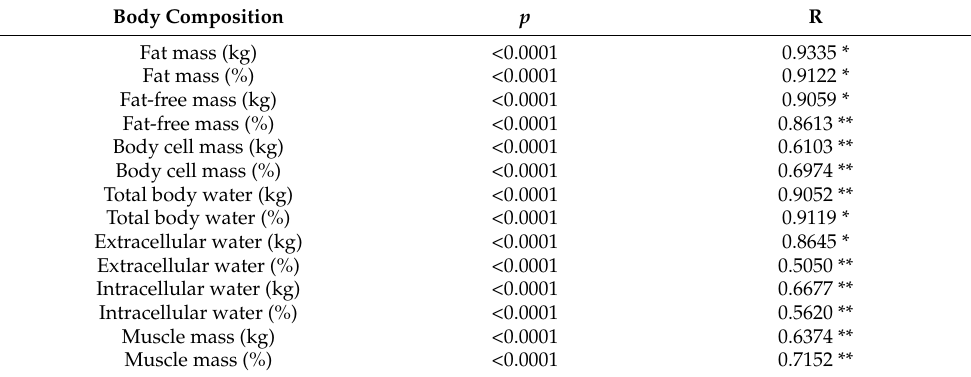
Table 2. Analysis of the correlations of the body composition results in the studied group of Caucasian young normal body mass women measured in the follicular phase in various positions (with arms abducted at least 30 ◦ and legs abducted at approximately 45 ◦ ; with arms and legs separated to not touch the body).